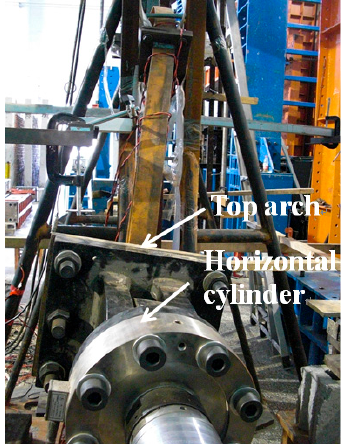
Figure 9. Top arch in model 4 after loading.